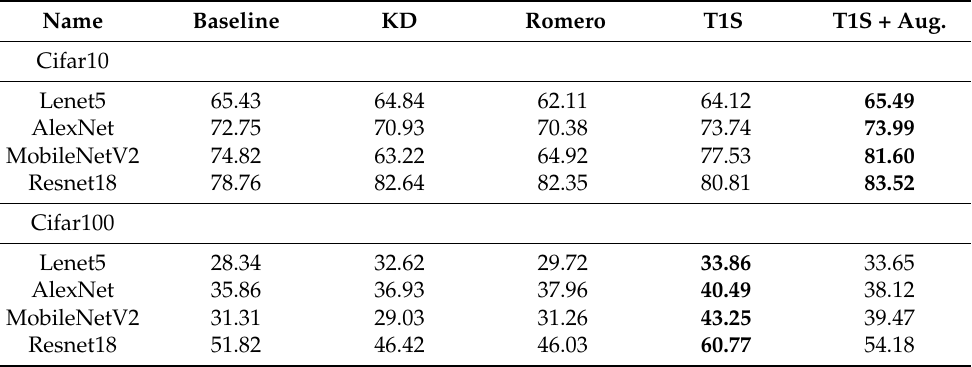
Table 1. Comparison of the baseline test accuracies on the Cifar10 and Cifar100 datasets with